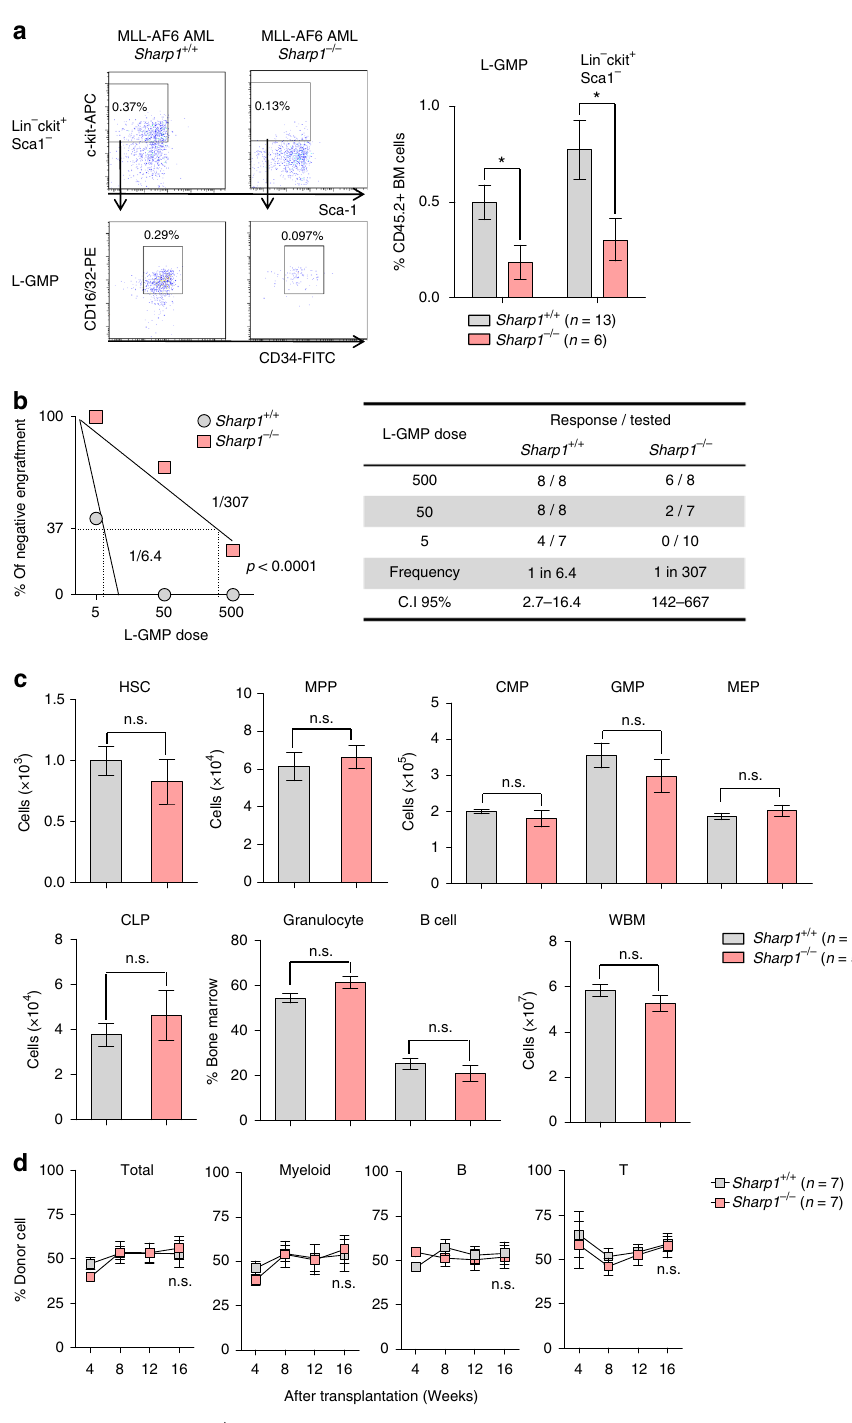
Fig. 5 Reduced leukemia-initiating cells in Sharp1 − / − MLL-AF6 AML. a Analysis of Leukemic-Granulocyte Macrophage Progenitor (L-GMP). Left panel: a representative fl ow cytometry plot, pregated on lineage-negative cells, and then on c-kit + Sca1 – CD34 + CD16/32 + cells; shown are percentage of total CD45.2 + bone marrow (BM) cells. Percentage of the gated populations were shown. Right panel: Graphical presentation of percentage of L-GMP and Lin – c-kit + Sca1 – cells in CD45.2 + BM cells. The graph is presented as mean ± s.e.m. b Limiting Dilution Assay (LDA). The indicated numbers of FACS-sorted L- GMP (MLL-AF6 AML Sharp1 + / + and Sharp1 − / − ) cells were transplanted into sublethally irradiated congenic mice. c HSPC and whole bone marrow (WBM) cell number from a femur and a tibia, and percentage of BM mature myeloid cells (Gr1 + CD11b + ) and B (B220 + ) are graphed. HSC (hematopoietic stem cell = CD150 + CD48 – ), MPP (multipotent progenitor = CD150 – CD48 + ), GMP (granulocyte-macrophage progenitor = CD34 + CD16/32 + ), CMP (common myeloid progenitor = CD34 + CD16/32 – ), MEP (megakaryocyte-erythroid progenitor = CD34 – CD16/32 – ), CLP (common lymphoid progenitor = IL7R + Flk2 + ), and WBM. d 500,000 WBM cells from Sharp1 + / + or Sharp1 − / − mice were transplanted into irradiated recipient mice along with 500,000 congenic WBM cells as competitor cells. Percentage of donor in peripheral blood was monitored for 16 weeks after transplantation. The graphs are presented as mean ± s.e.m, *p <